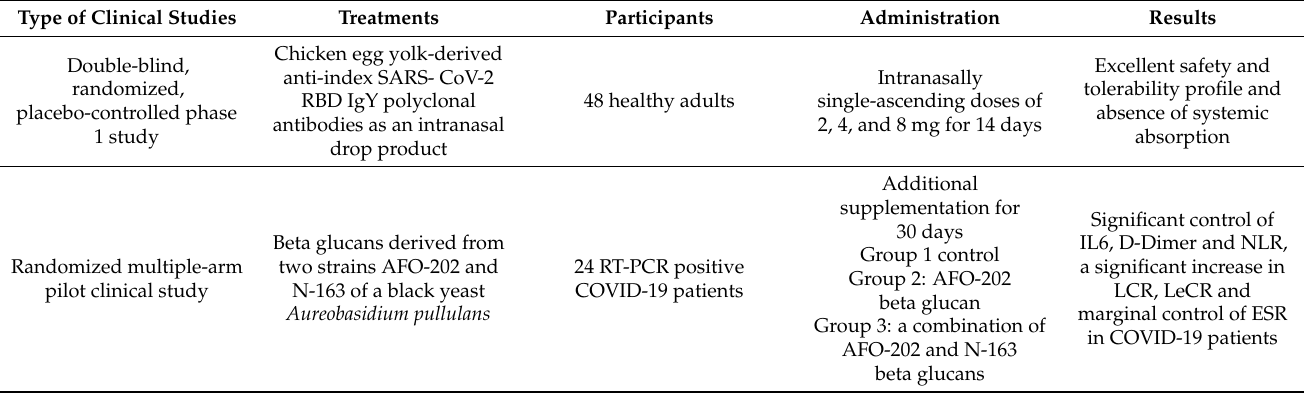
Table 4. Recent clinical